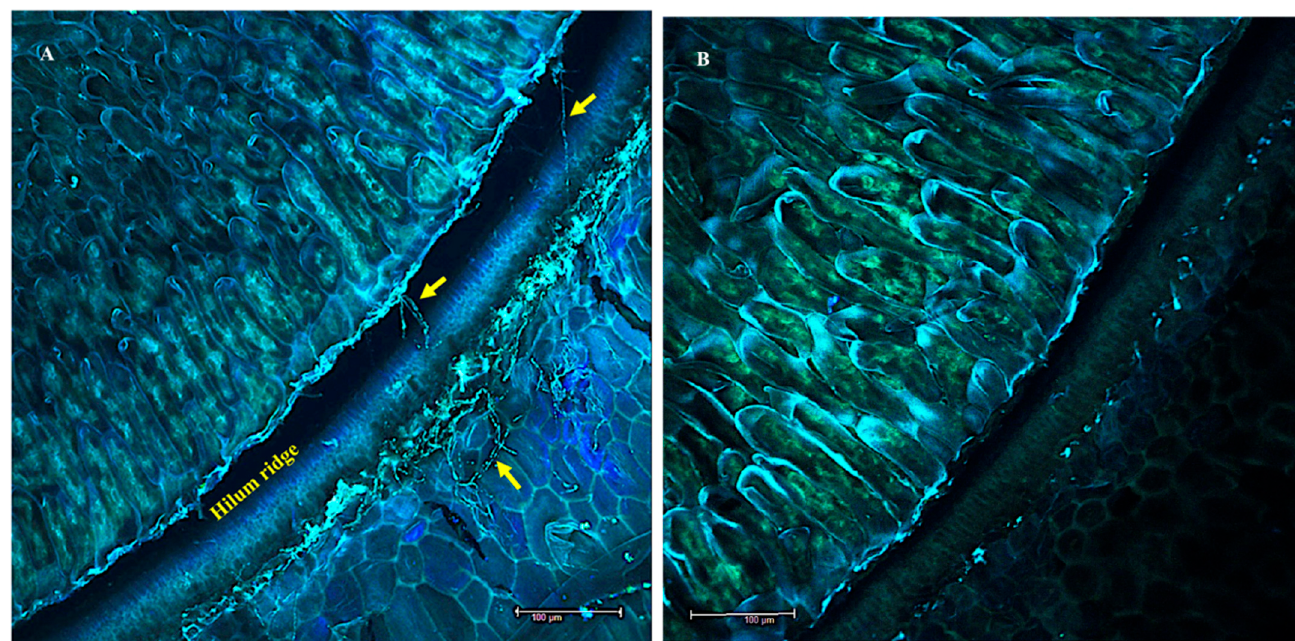
Figure 2. Fluorescent laser scanning confocal microscope images of the hilum from Ipomoea carnea seeds; positive ( A ) and negative ( B ). Cyan (blue + green) autofluorescence of loose network of mycelia around the hilum and in the hilum crevice indicated by the arrows. No mycelia were observed in the hilum of negative seeds ( B ). Scale bar—100 μ m.